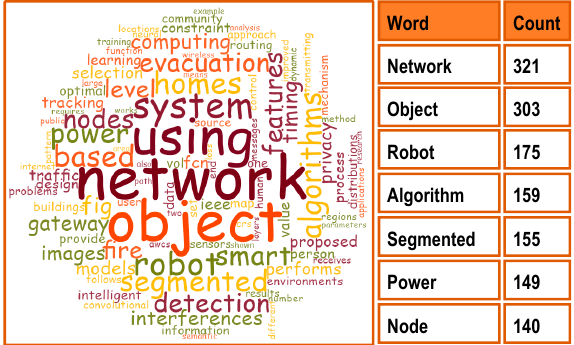
Figure 8. The word cloud based on the frequency of exact words, and the frequency of words within Group 2 of the AISH database considering word stems.